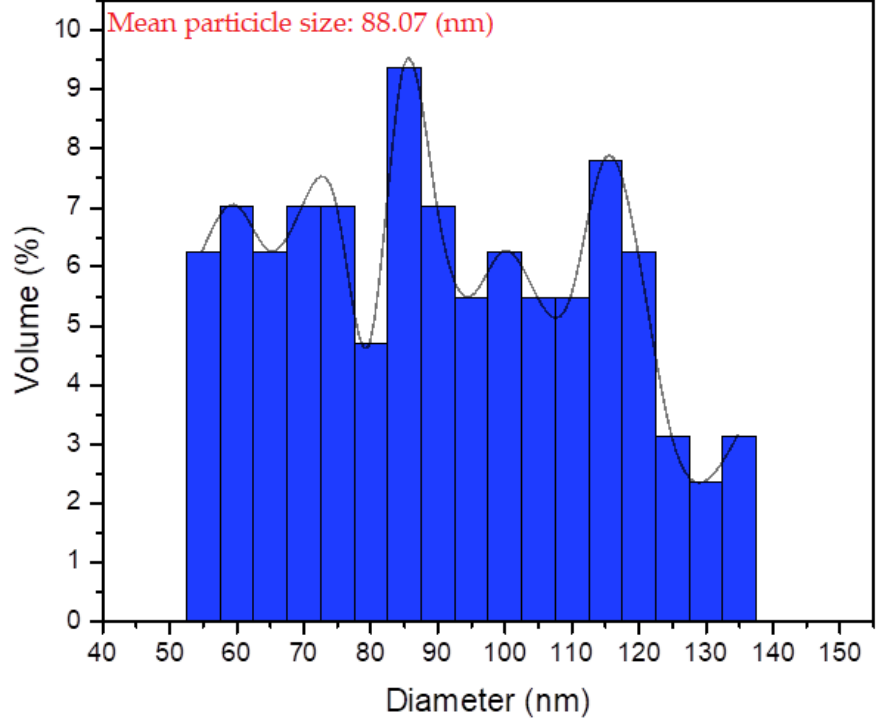
Figure 5. Various proportions of particle size distribution for TGF nanoparticles.